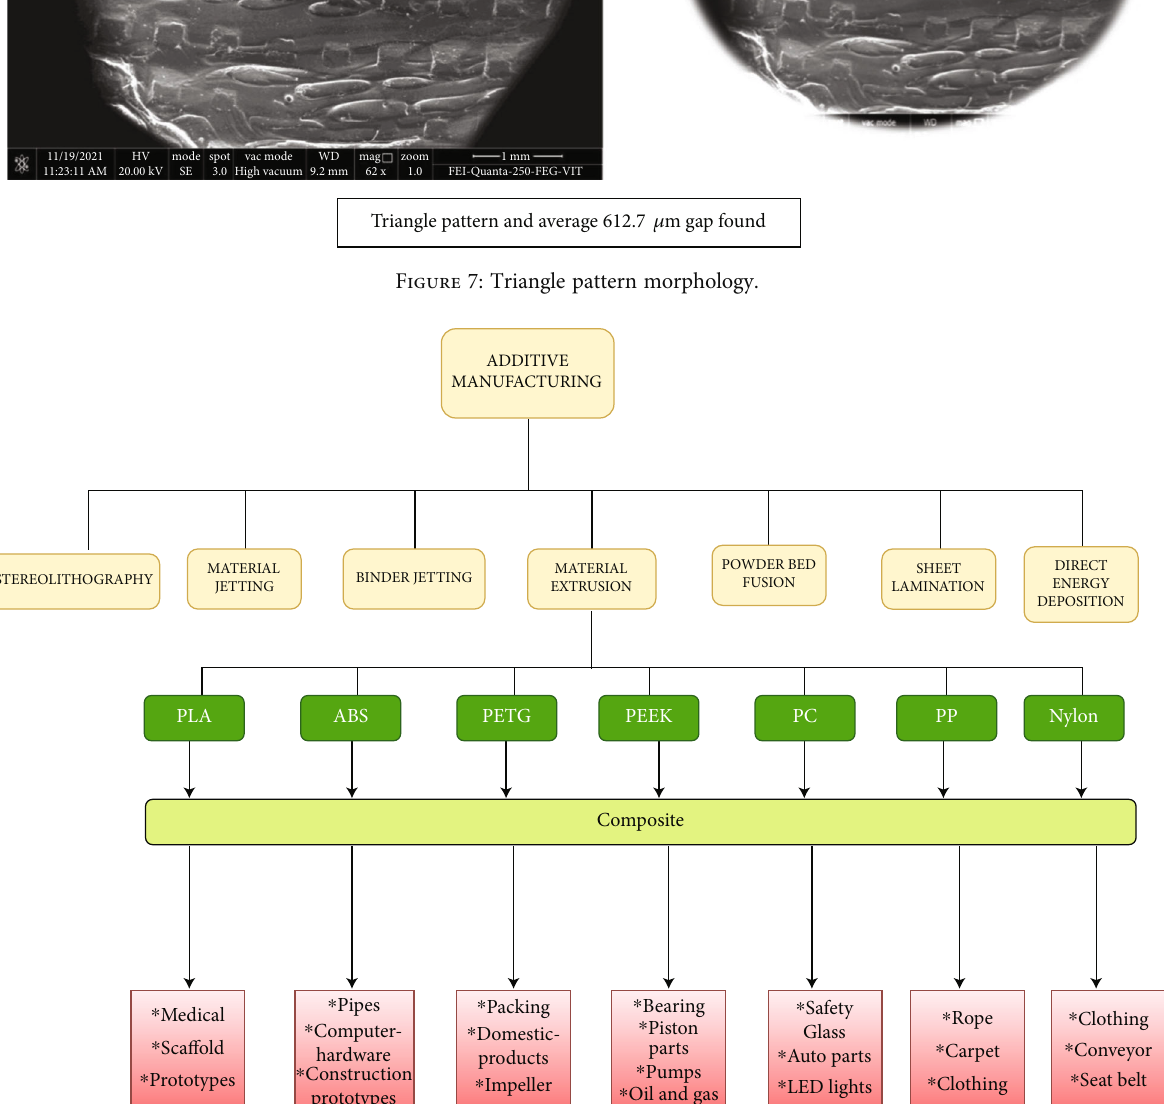
Figure 8: Additive manufacturing process and material extrusion ’ s raw material with the